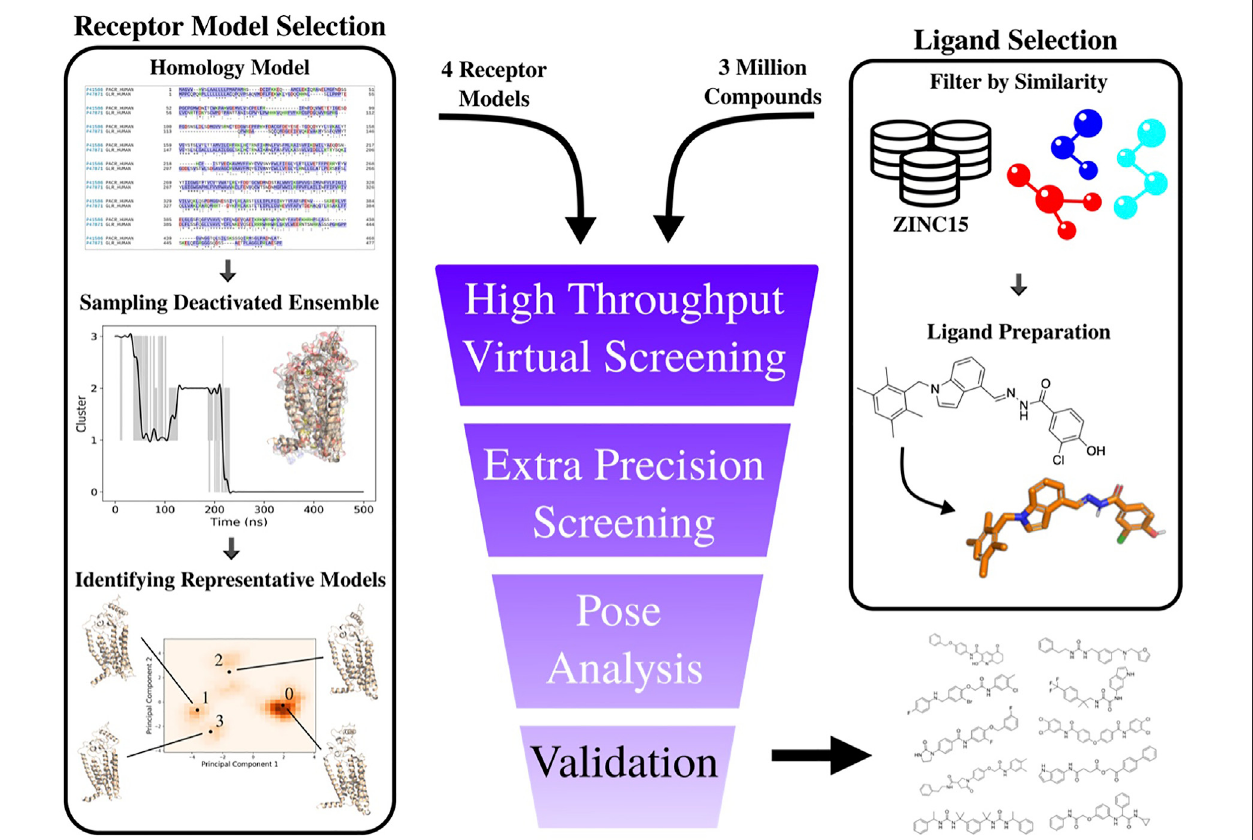
FIGURE5| Overviewofcomputationalwork fl owfordevelopmentofPAC1Rantagonists.RightColumn:selectionofinputligandsfromastructuredatabase(inthis exampletheZINC15(SterlingandIrwin,2015)database).Custom fi lterswereusedtoselectrawstructureswithdesirableproperties(molecularweight,log P ,etc.).These structures are then prepared using Schrödinger ’ s ligprep software program. Left column): the PAC1null homology model is constructed from the protein ’ s sequence, simulated for 500 ns, and the raw coordinates are analyzed. The representative structures are used in ensemble docking. Hit compounds are selected based on visual inspection of the